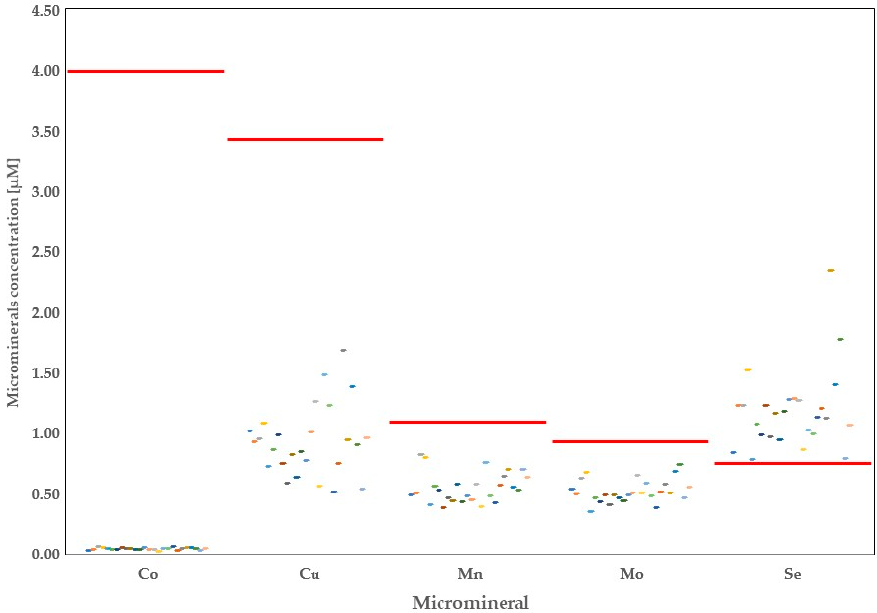
Figure 3. Distribution of microminerals (cobalt, copper, manganese, molybdenum, and selenium) in Alberta milk samples with regards to world averages (red line).